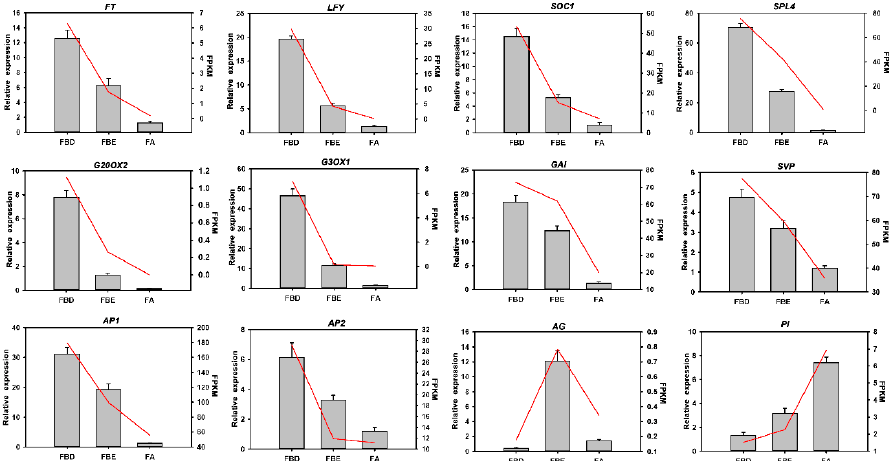
Figure 10. Validation of the expression of flower development-related genes by qRT-PCR analysis. Bar charts indicate values of qRT-PCR. Line plots indicate values of fragments per kilobase per million (FPKM). Error bars indicate the standard deviation of three biological replicates.